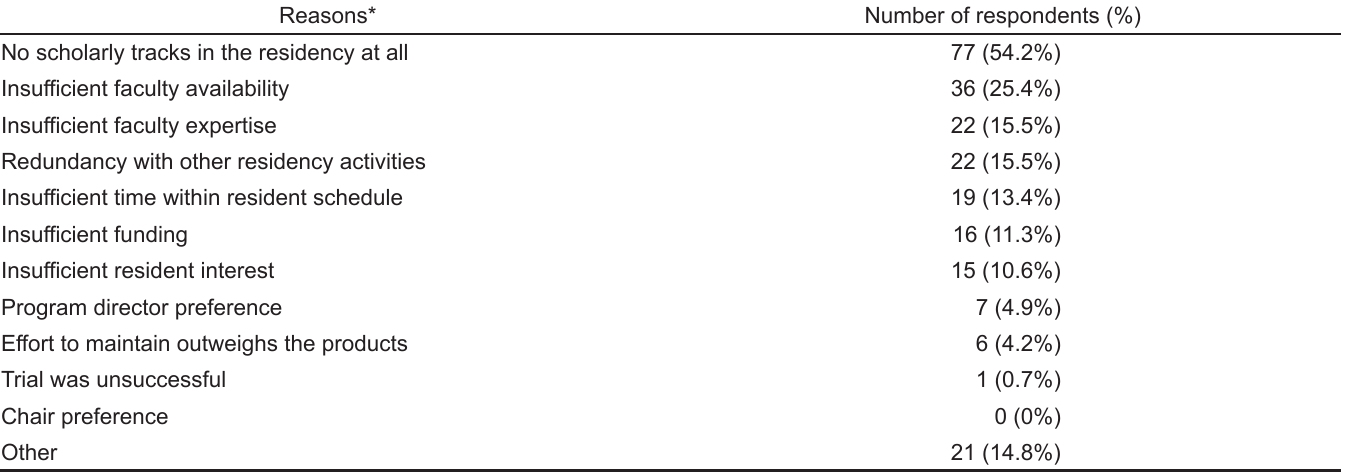
*Responders were allowed to select more than one